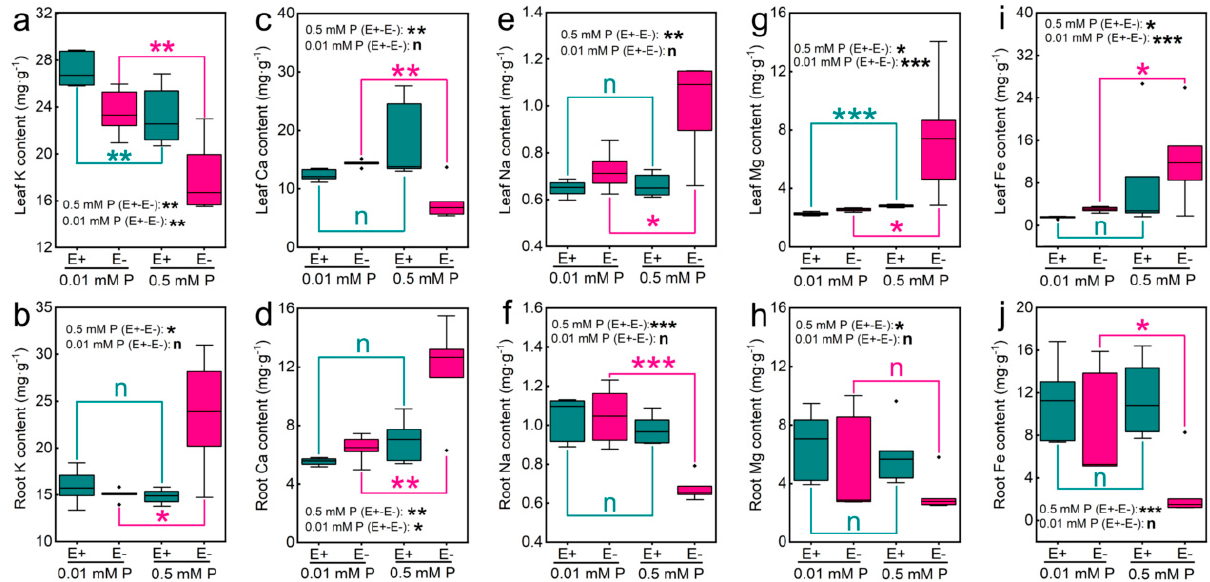
Figure 3. The content of K, Ca, Na, Mg, and Fe of leaves ( a , c , e , g , i ) and roots ( b , d , f , h , j ) in E − and E+ plants at 0.01 and 0.5 mM P. *, **, and *** showed differences at p < 0.05, p < 0.01, and p < 0.001, respectively.